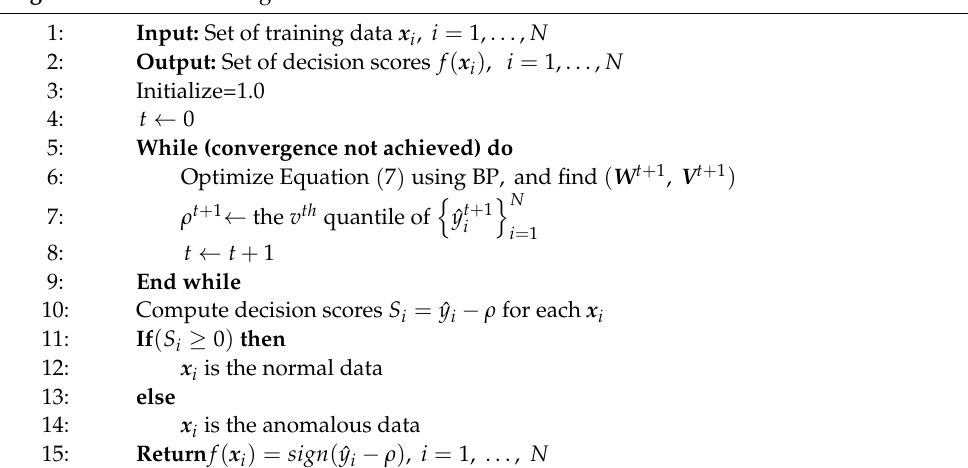
Algorithm 1 OC-LSTM